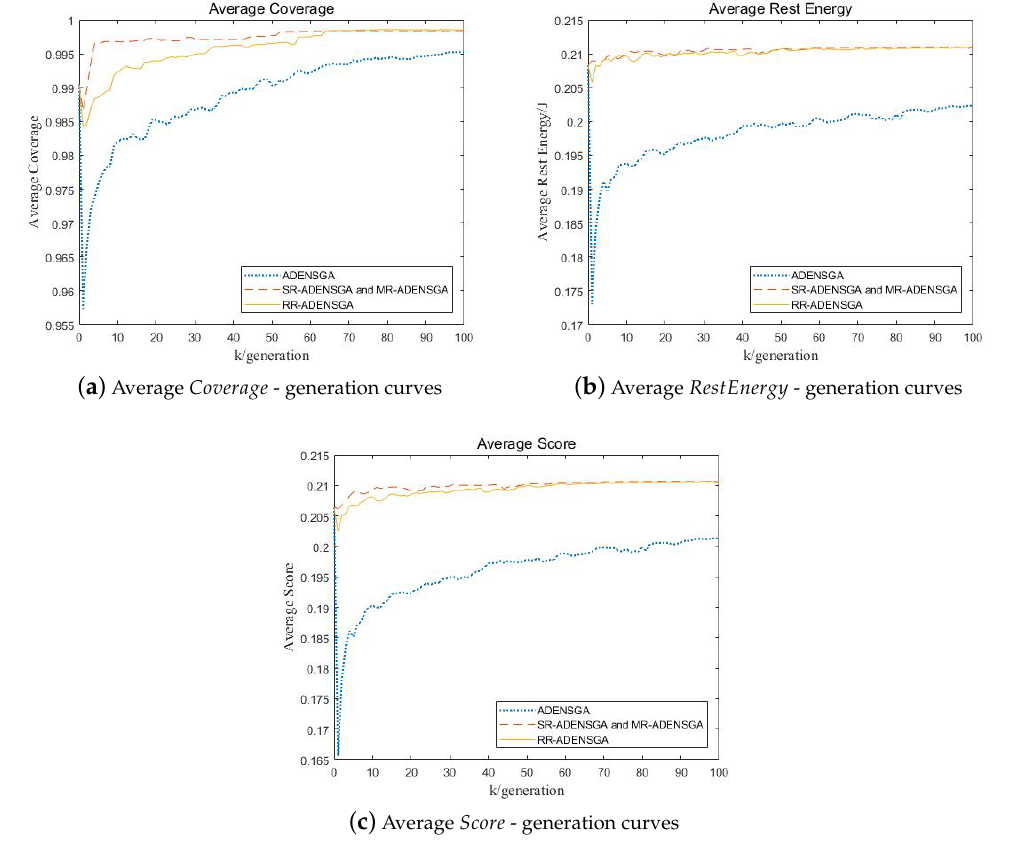
Figure 9. Comparison of Optimization Results of Different Algorithms Changing With Generation in Situation 9.